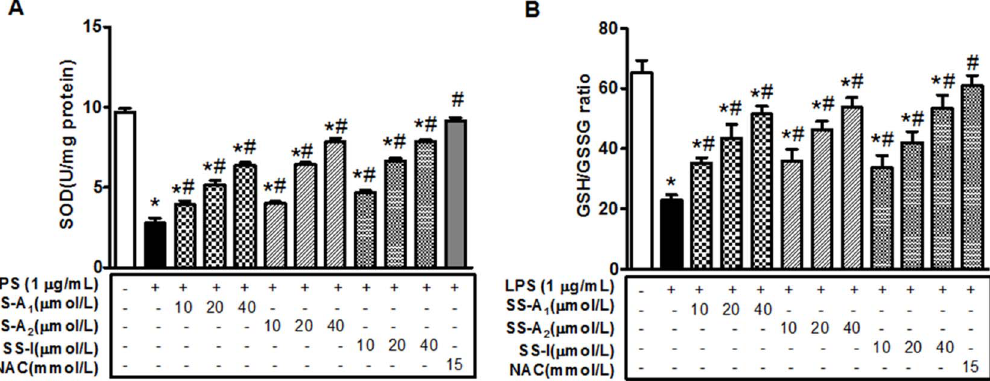
Figure 8. Soyasaponins increase SOD activity and GSH/GSSG ratio in the LPS-stimulated macrophages. Macrophages were pre-treated with NAC (15 mmol/L) or soyasaponin (A 1 , A 2 or I) for 30 min, and then stimulated with LPS (1 m g/mL) for 16 h as noted, followed by measurements of SOD activity ( A ) and GSH/GSSG ratio ( B ). Results are presented as means 6 SD of 3 independent experiments. *: P , 0.05 vs. control. # : P , 0.05 vs. LPS alone.